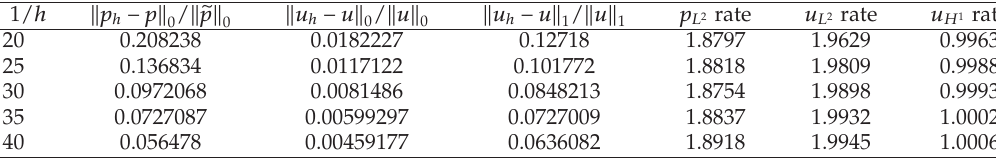
Table 2: Numerical results for PPM in (cid:2) 6 (cid:3) with NCP 1 - P 1